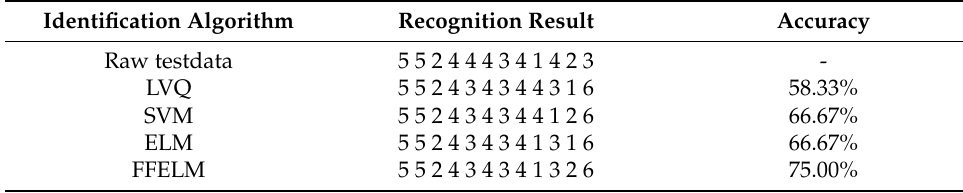
Table 5. Recognition results under different